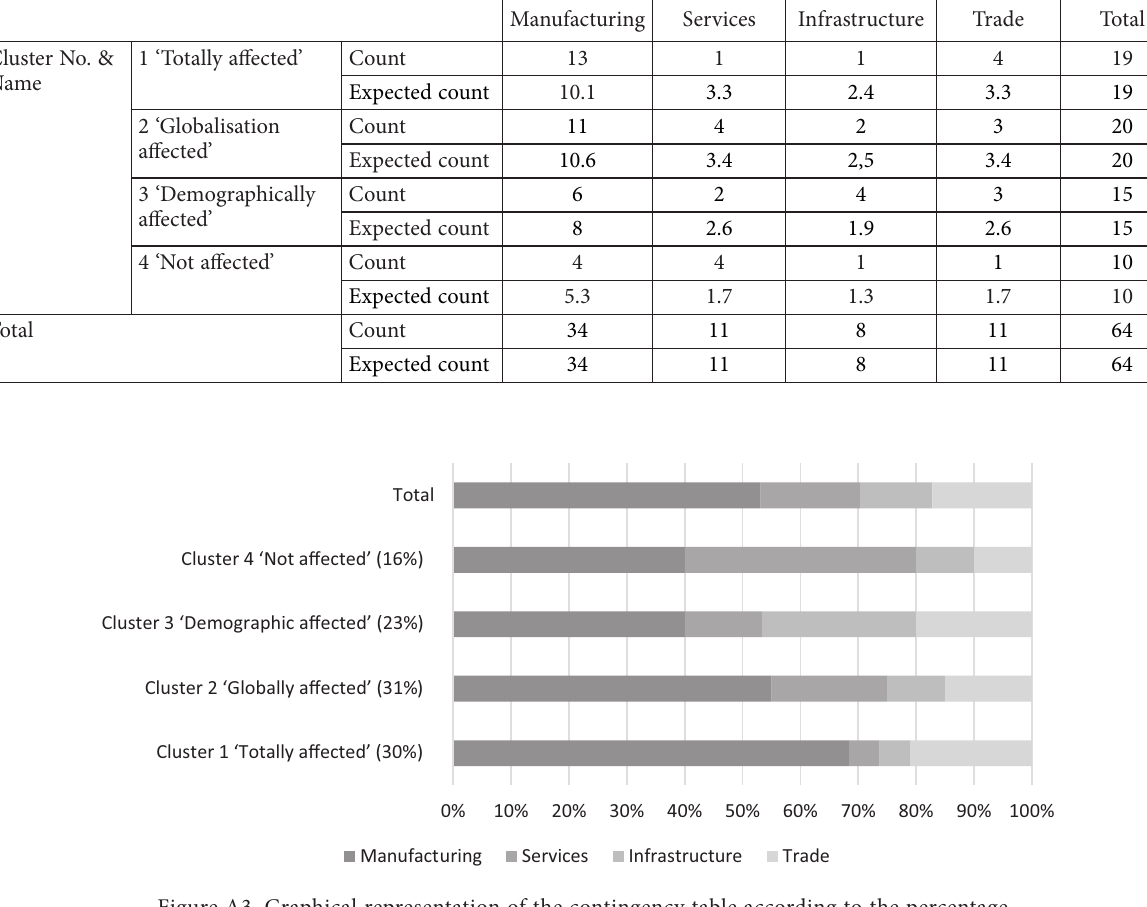
Figure A3. Graphical representation of the contingency table according to the percentage composition of clusters by their industry segments